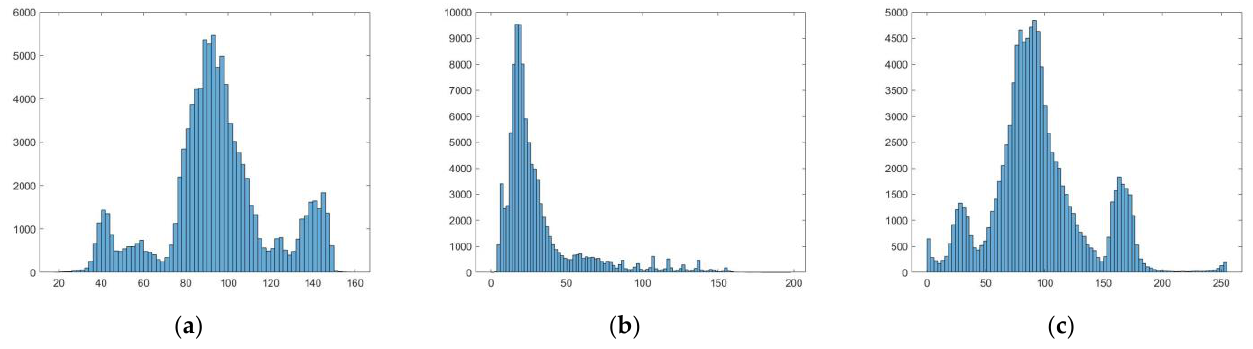
Figure 11. Histogram comparison results, ( a ) the result of original image, ( b ) the result of DTMS, ( c ) the result of proposed.